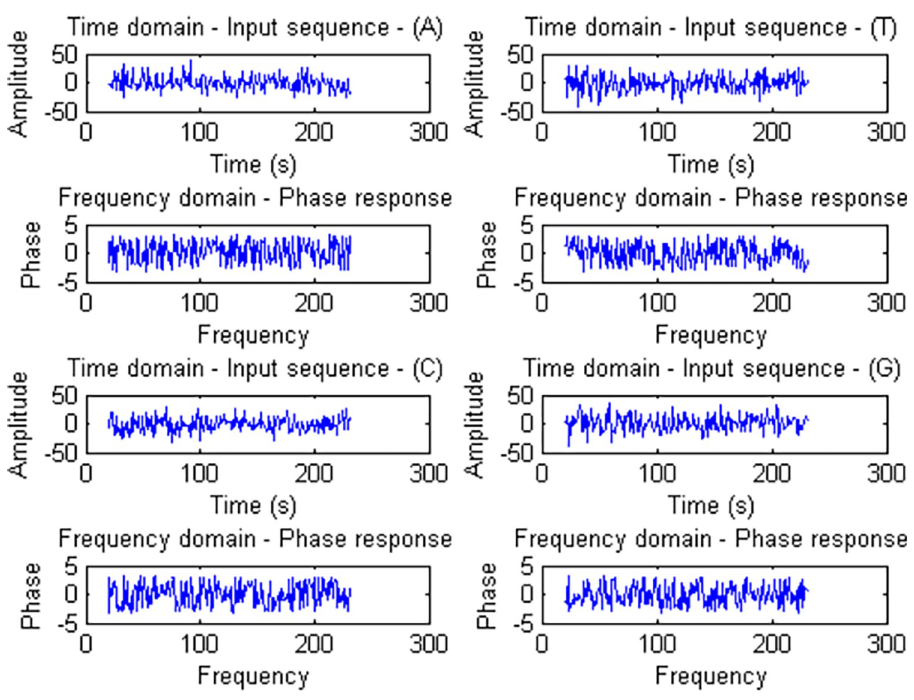
Fig 2. Pair-wise comparison of sequence similarity from Fourier frequency domain for all 30 genes.